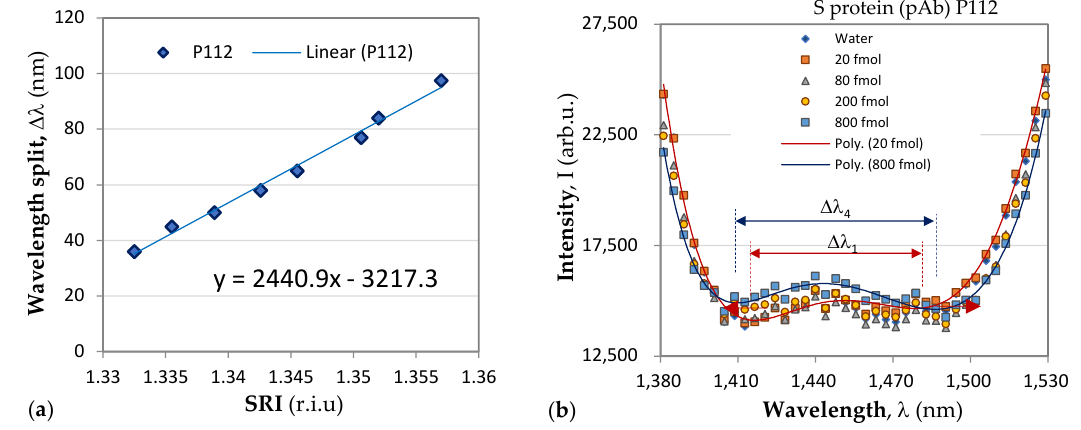
y = 2440.9x - 3217.3